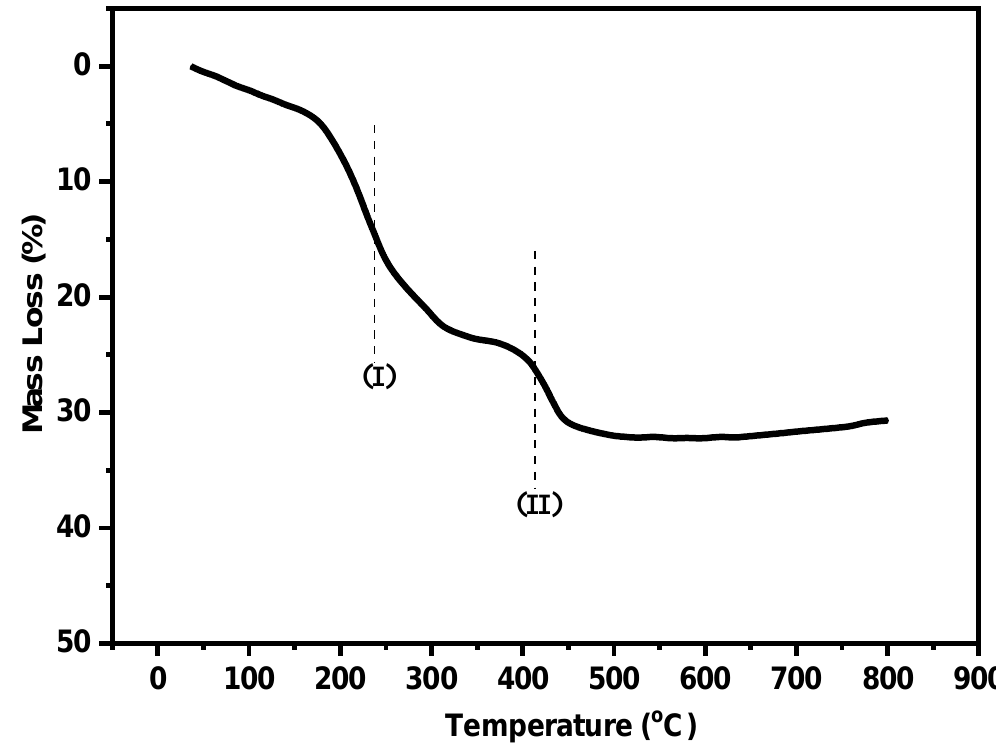
Figure 2. TG curve obtained for the as-obtained Cr 2 O 3 tetrahydrate.